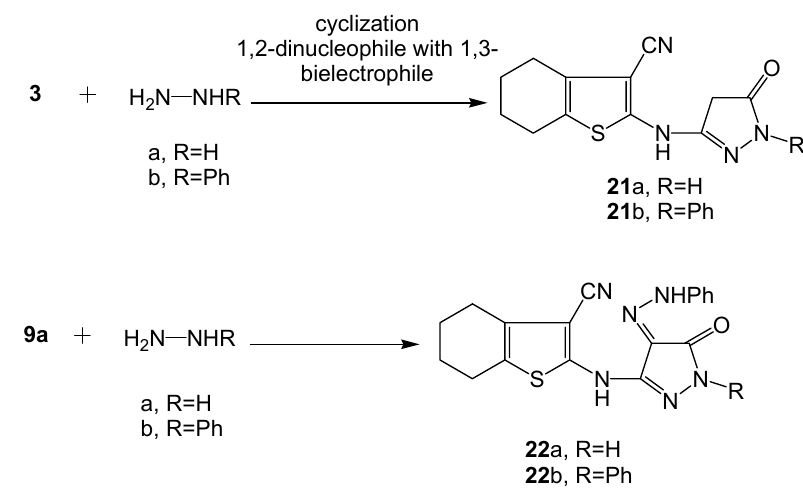
Scheme 8. Synthesis of functionalized oxopyrazole dye precursors 21a-b and respective dyes 22a-b